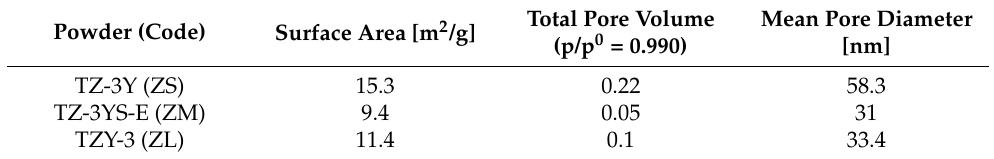
Table 3. BET results of different